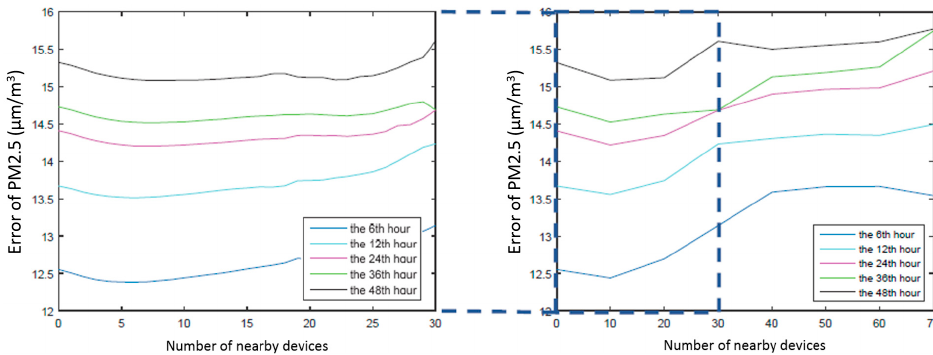
Figure 13. PM2.5 RMSE of different parameters of n ( a ) from 0 to 30 and ( b ) from 0 to 70